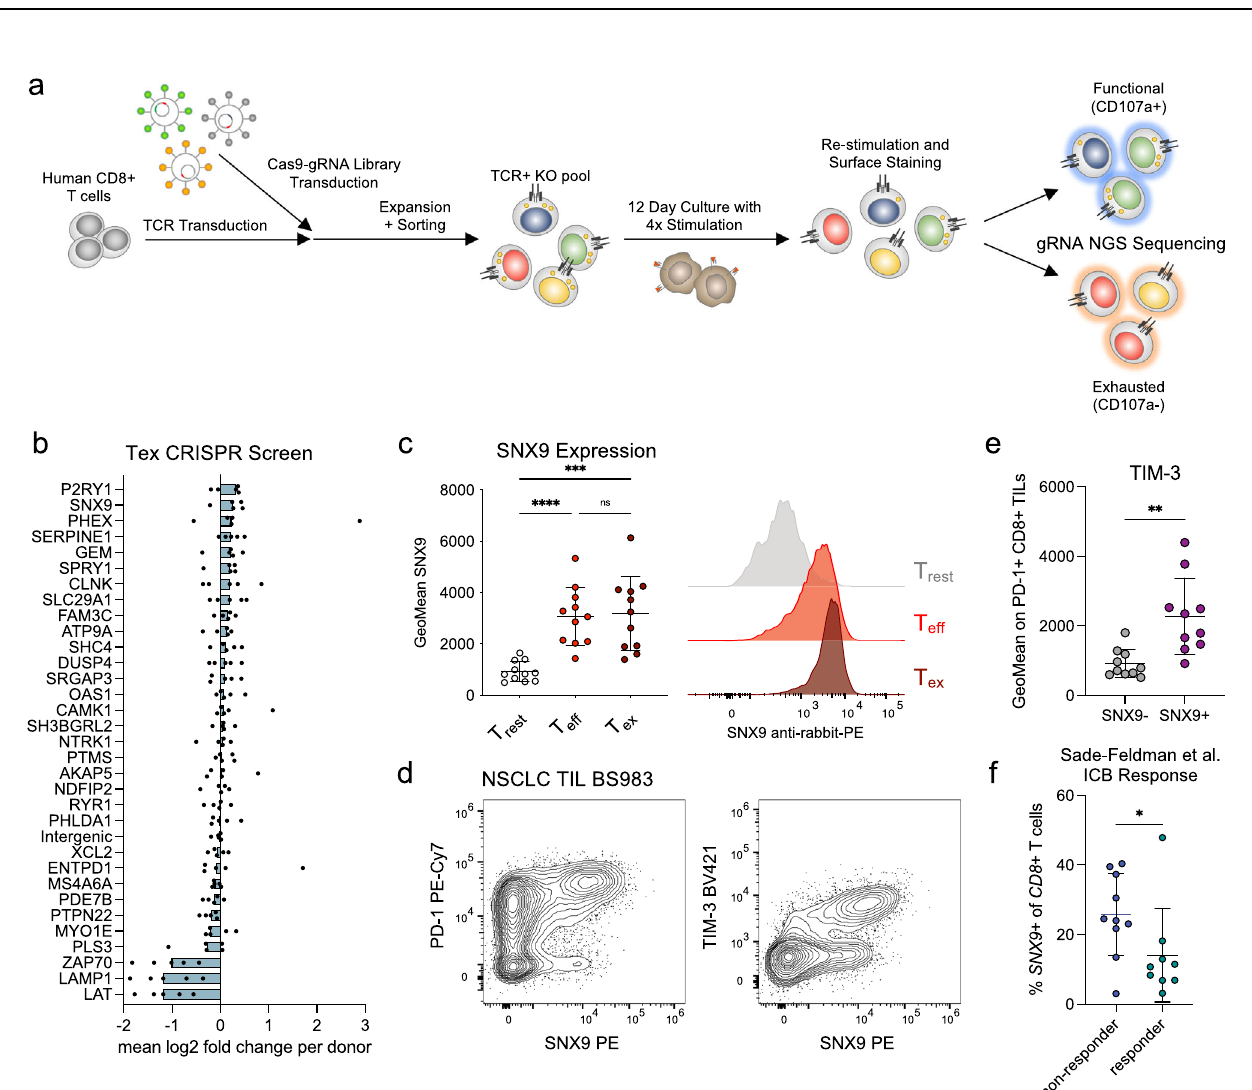
secretionmeasuredbyELISAafter4daysco-cultureofT eff orT ex withMDA-MB-231 cells loaded with 100nM NY-ESO-1-9V peptide in presence of either 10 μ g/ml humanIgG4isotypecontroloranti-PD-1antibody(Nivolumab).Statisticsisapaired 2-way-ANOVA with Holm-Sidak correction with n =5 donors. i Heatmap of all dif- ferentially regulated genes between the four conditions showing row-scaled log- cpms and clustered using k-means (numbersindicated on the left).Selected genes associated with exhaustion or functionality are labeled on the right. n =4 donors. j Gene set enrichment analysis comparing mRNA expression of the different con- ditions for the Zheng. et al PanCancer T cell states. Color represents the mean log foldchangeandthesizethe-log10falsediscoveryrate(FDR). c - d ; f - g 1-wayANOVA statisticswithHolm-Sidakcorrection,MeanandSDareshown.* p <0.05,** p <0.01, *** p <0.001, **** p <0.0001. Source data and exact p-values are provided as a Source Data fi le.